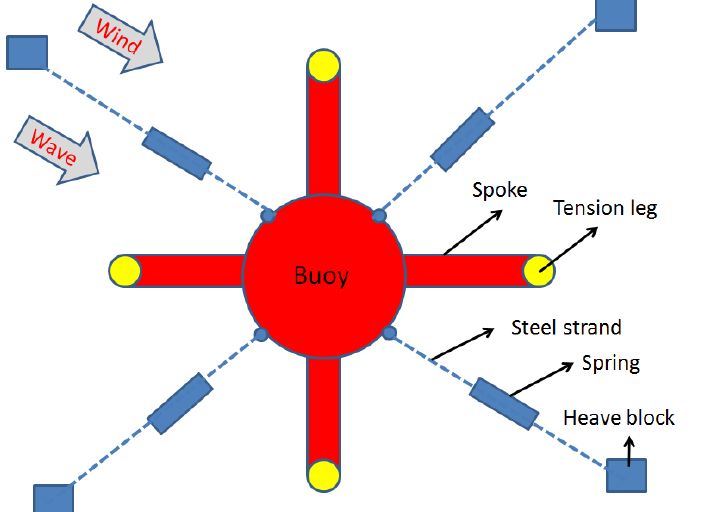
Figure 2. A sketch of the combined tension leg-mooring line system in